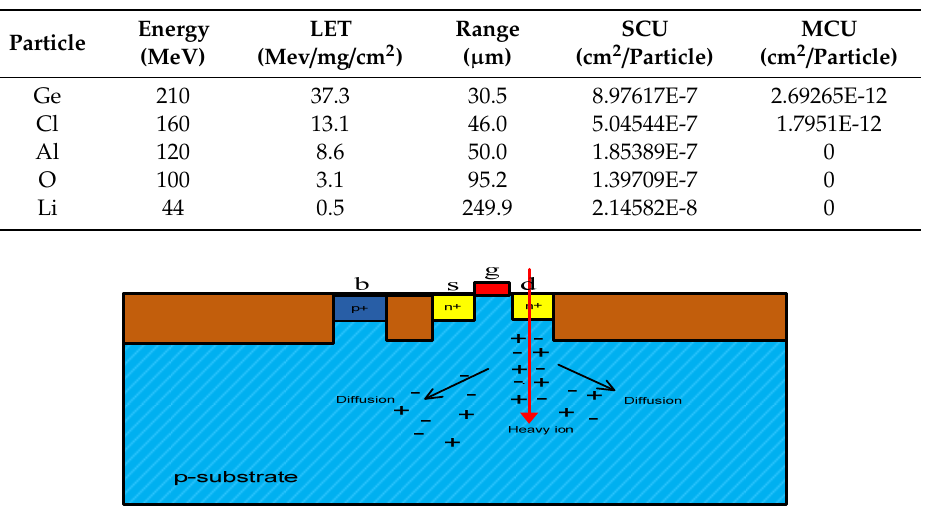
Figure 7. A particle strikes the drain of transistor and carriers diffuse.